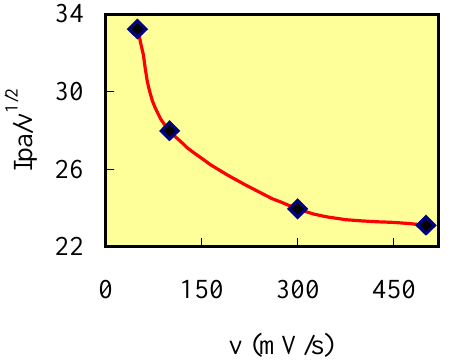
Figure 3 . The variation of anodic peak current function (Ipa/v 1/2 ) ( µΑ. s 1/2 .mV -1/2 ) vs. scan